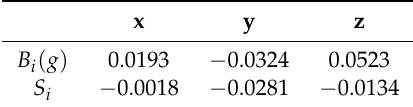
Table 2. Null bias and scale factor for each